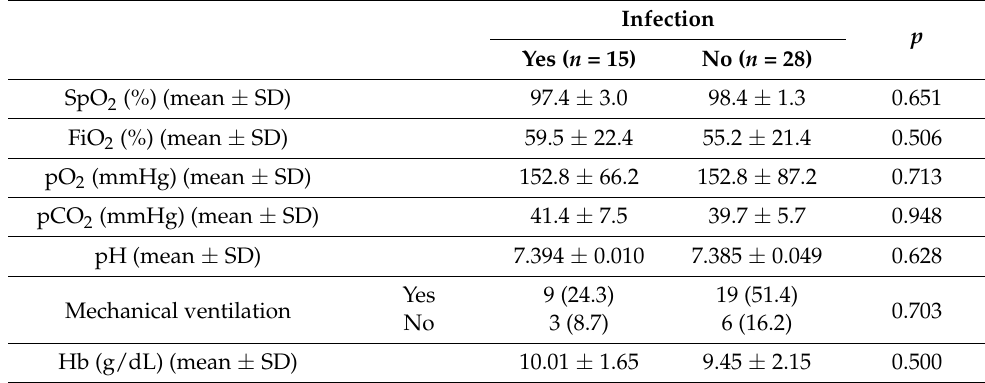
Table 12. Univariate Analysis of Variables from ICU Patients on Infection.